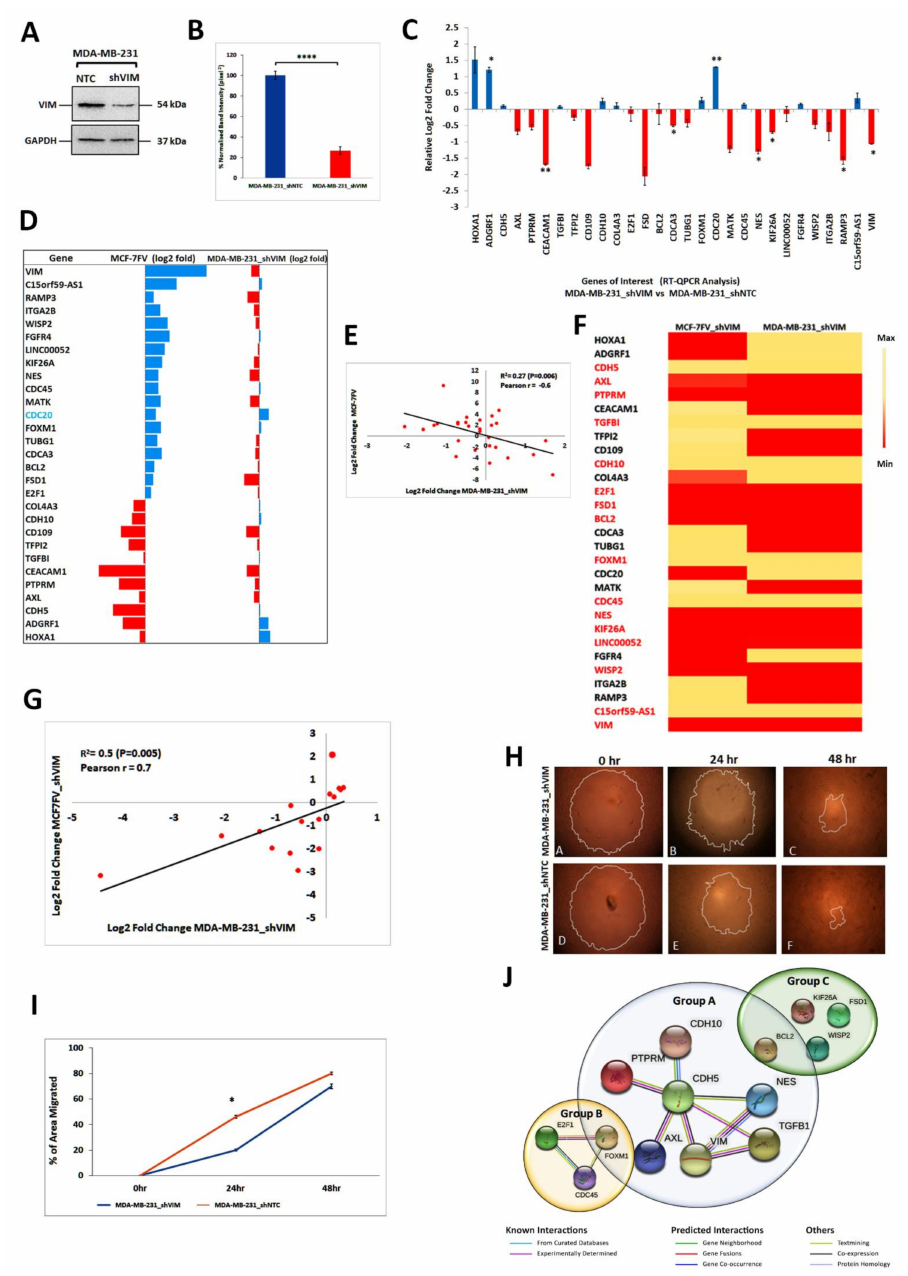
Figure 5. Knockdown of vimentin in MDA-MB-231 cells by shRNA. ( A ): Vimentin expression